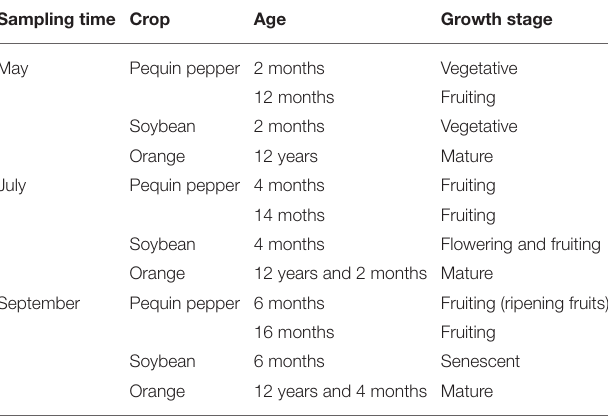
TABLE 1 | Sampling details for Pequin pepper, soybean, and orange tree at each sampling